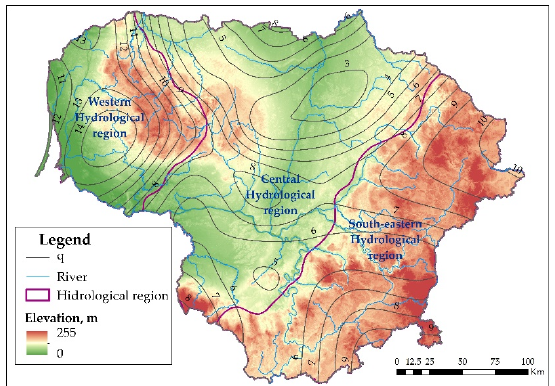
Figure 4. Spatial distribution of specific runoff (q, l s -1 km − 2 ) in the territory of Lithuania according to the ensemble of three models in the reference period (1986–2005).